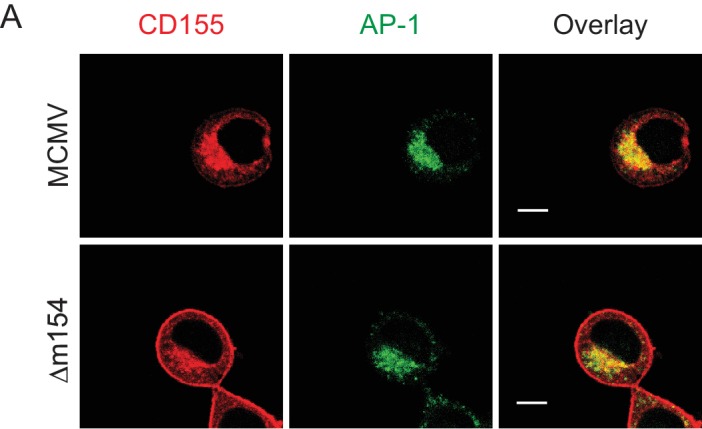
CD155 accumulates in AP-1 compartment in cells infected with the virus lacking m154.Confocal images of DC2.4 cells infected with 3 PFU/cell of Δm154 or control WT MCMV for 20 hr. Cells were stained with anti-mouse mPVR.01 followed by anti-rat IgG F(ab')2-TRITC, and anti-mouse γ1-adaptin followed by anti-rabbit F(ab')2-FITC. Scale bar: 10 μm.